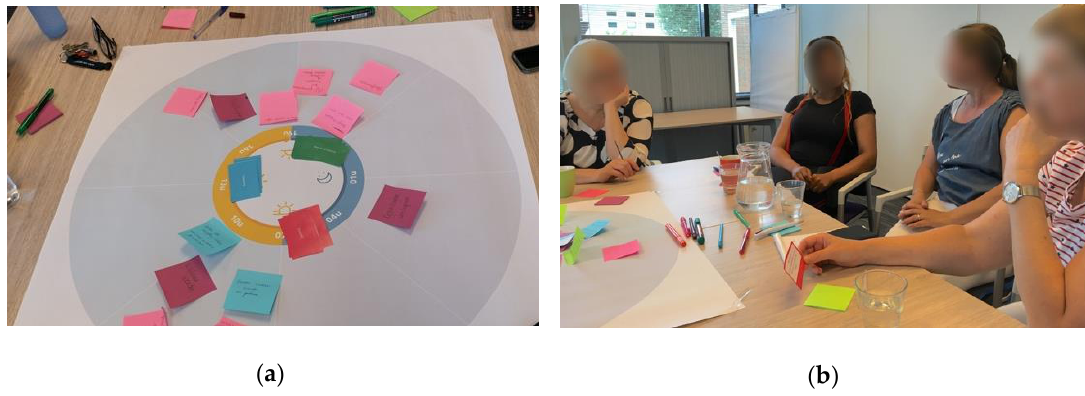
Figure 3. During the second step of the workshops, the professional caregivers were asked to map statements from literature to practice: ( a ) The cards with statements from literature were stacked in piles, face-down on the poster as in a board game. ( b ) Each caregiver was asked in-turn to draw a card and to relate the statement to their own experience, after which the group discussed the statement.